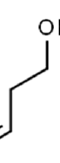
Figure 11. Chemical structure of ( Z, Z )-3,6-nonadienol. Volatile aldehydes, also a chemical class formed by the lipoxygenase pathway from fatty acids [139,149], are well-known for their green note odour. ( E )-2-nonenal and ( Z )-3- hexenal (Figure 12), despite their different structures, also originate from different fatty acids (( E )-2-nonenal, from linoleic acid and ( Z )-3-hexenal from linolenic acid) and are de- scribed as presenting other sensory attributes. “Penetrating”, “waxy” [150] or “fatty” [152] characteristics have been linked to ( E )-2-nonenal, while, for ( Z )-3-hexenal, “leafy”, “power- ful”, “strawberry leaf”, “winey”, “green leaves”, “apple-like”, “leaf-like” and “cut grass” attributes have also been